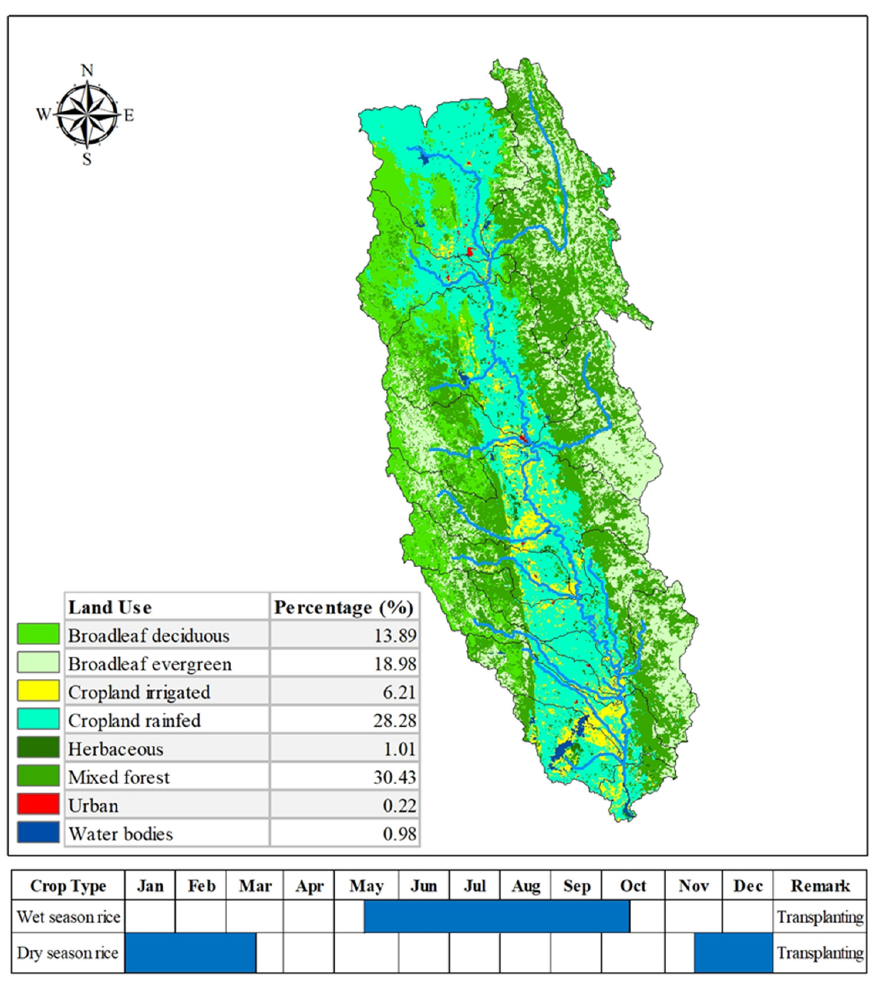
Figure 5. Land use information in 2015 derived from the European Space Agency (ESA) and crop calendar used in the study.